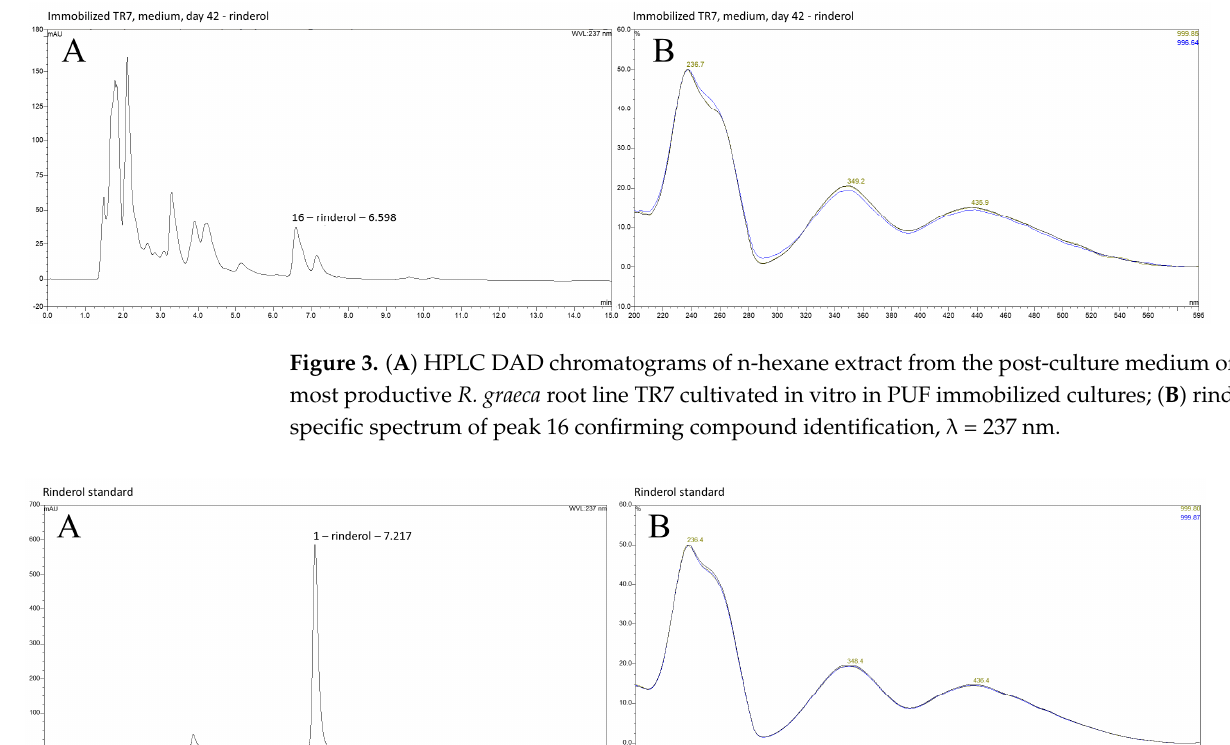
11 confirming compound identification, λ = 237 nm.